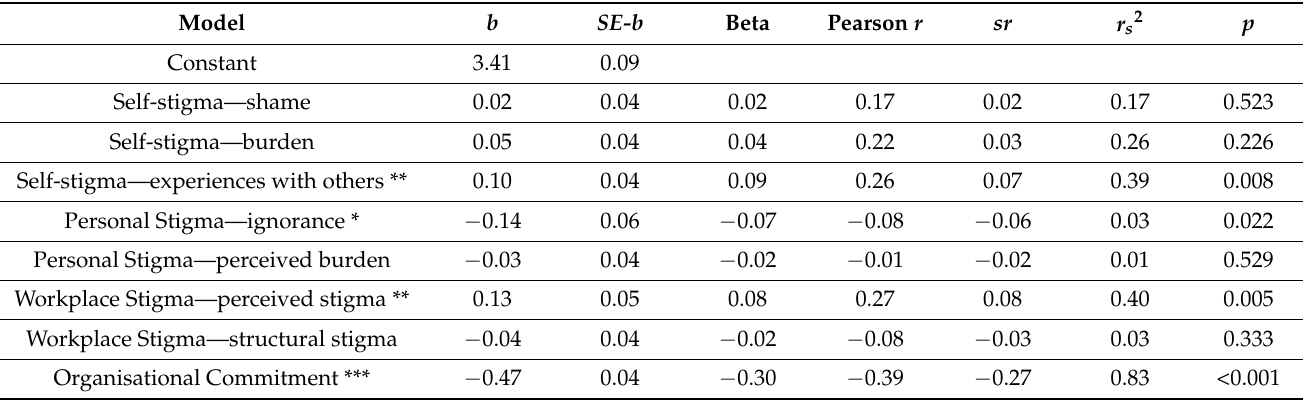
Table 4. Standard Multiple Regression Results for Self-stigma, Personal Stigma, and Workplace Stigma Predicting Police and Emergency Service Personnel’s Reported Impact a of the Claims Process for Psychological Injuries on their